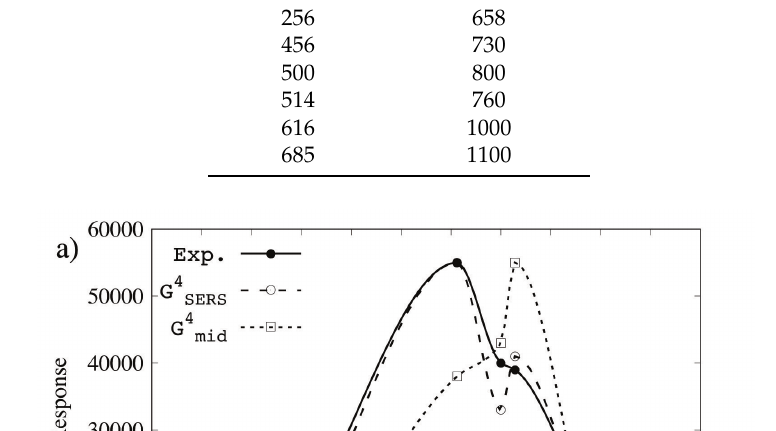
Table 1. Periodicities and diameters for experimental plasmonic crystals.